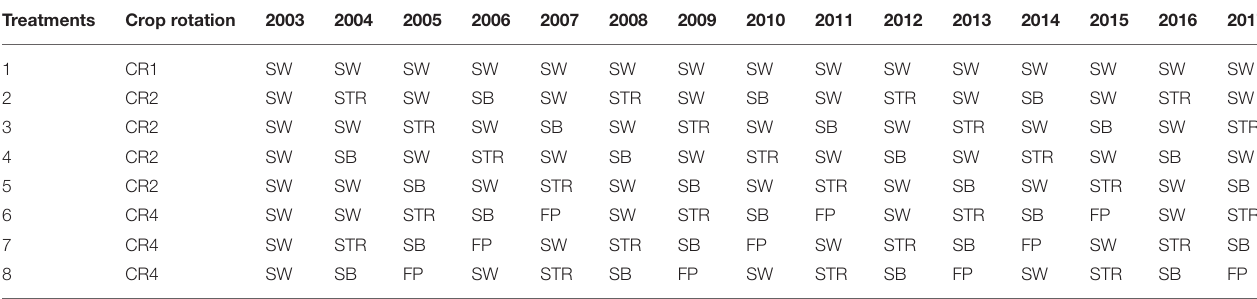
TABLE 1 | Crop rotation treatments in 2005–2017. Treatments Crop